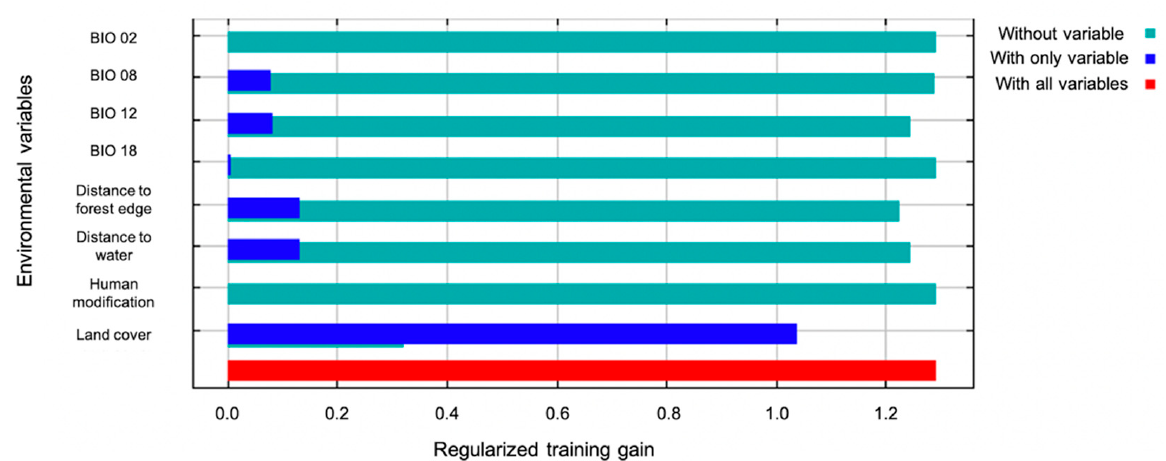
Figure 3. Jackknife test of variable importance for the spatial distribution model of nine-banded armadillos in southern Illinois during 2016–2020. The variable with the highest gain when in isolation and the lowest decrease in gain when omitted was land cover.